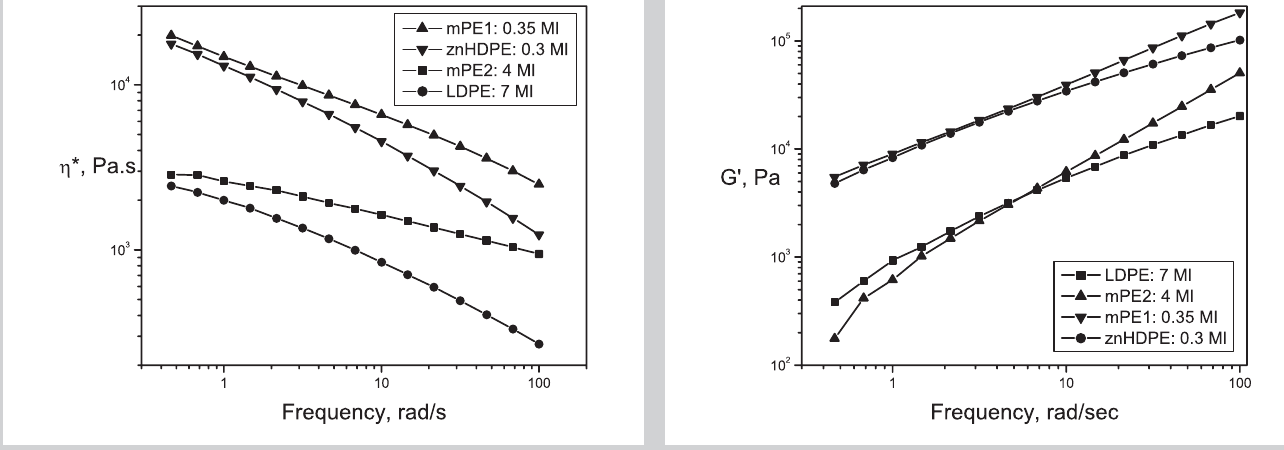
Figure 2 (left): Complex viscosity of neat polyethylenes as a function of frequency. Figure 3: Storage modulus as a func- tion of frequency of the neat